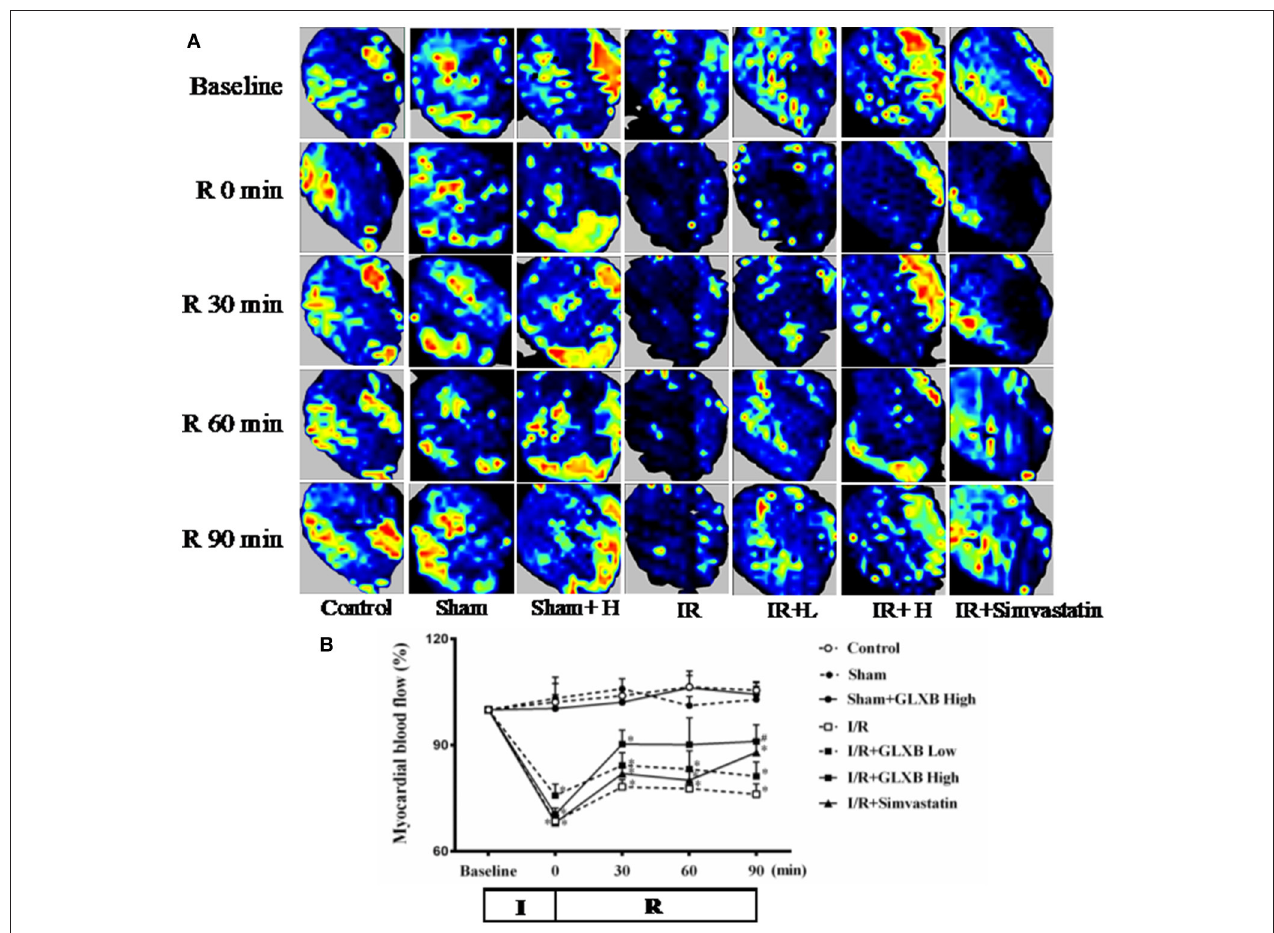
FIGURE 10 | The effect of GLXB on MBF after I/R in rats. (A) Color images of MBF acquired by Laser Scanning Doppler Perfusion Imager in Control, Sham, Sham + GLXB High, I/R, I/R + GLXB Low, I/R + GLXB High, I/R + Simvastatin groups at Baseline, 0, 30, 60, and 90min after reperfusion. (B) Time courses of MBF of rats subjected to I/R in various groups. The linear mixed effects models were analyzed for repeated measurement data, and least squares means were calculated between the groups of different time points. Data are mean ± SEM, n = 6. * P < 0.05 vs. Sham group, # P < 0.05 vs. I/R